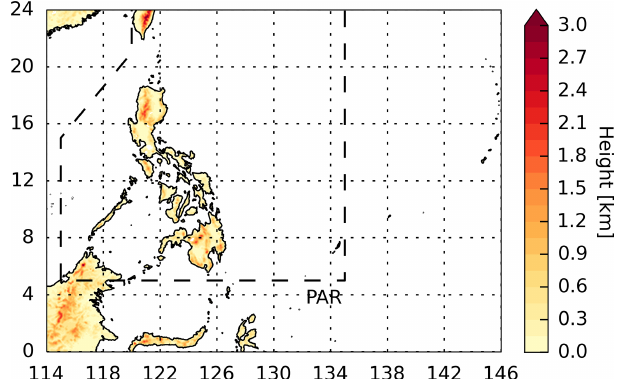
Figure 18. Philippine regional model domain and orography. The dashed black line shows the portion of the Philippine Area of Re- sponsibility (PAR) inside the domain.